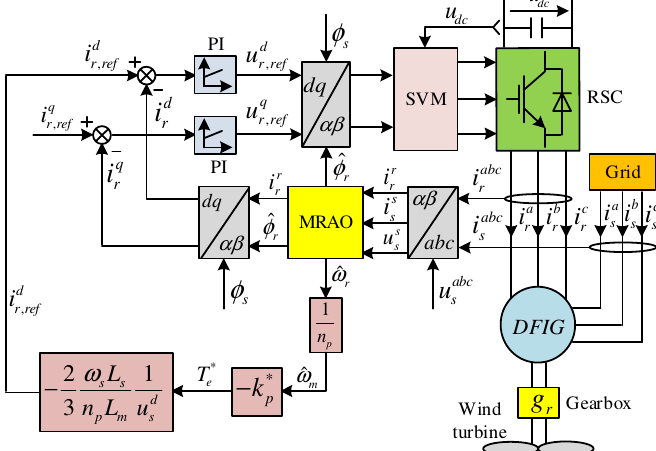
Figure 1. Schematic-diagram of the VOC technique for doubly-fed induction generators (DFIGs) with model-reference adaptive observer (MRAO) in wind turbine